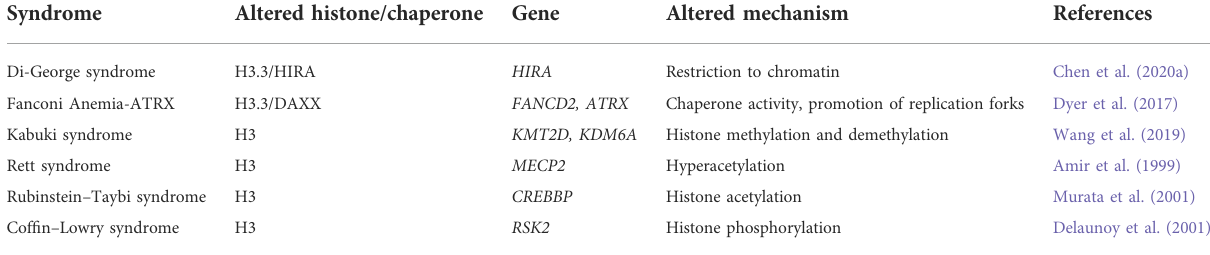
TABLE 2 General aspects of known chromatin-remodeling and associated-like